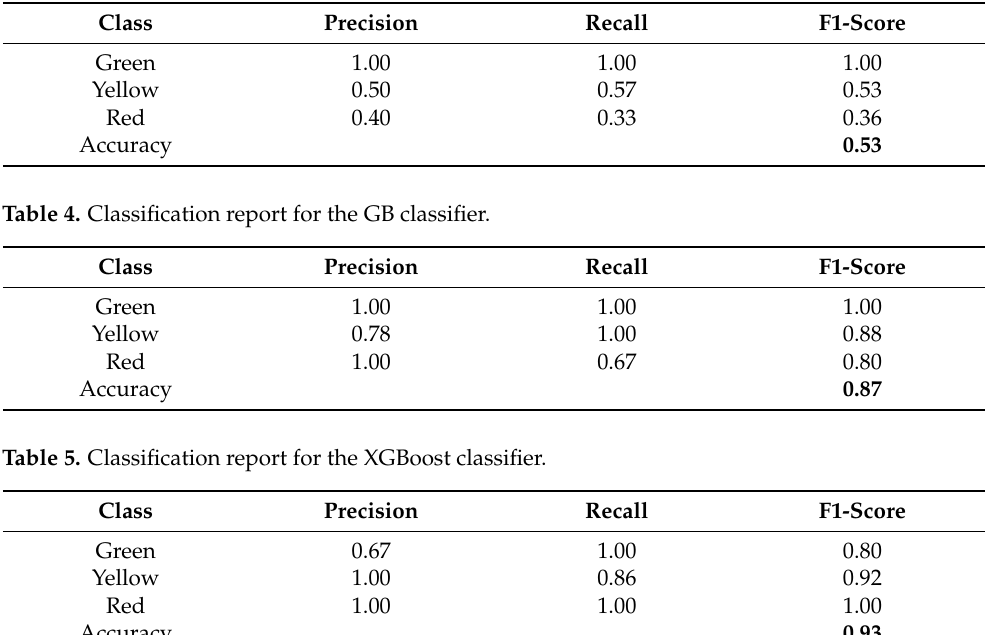
Table 3. Classification report for the MultinomialNB classifier.